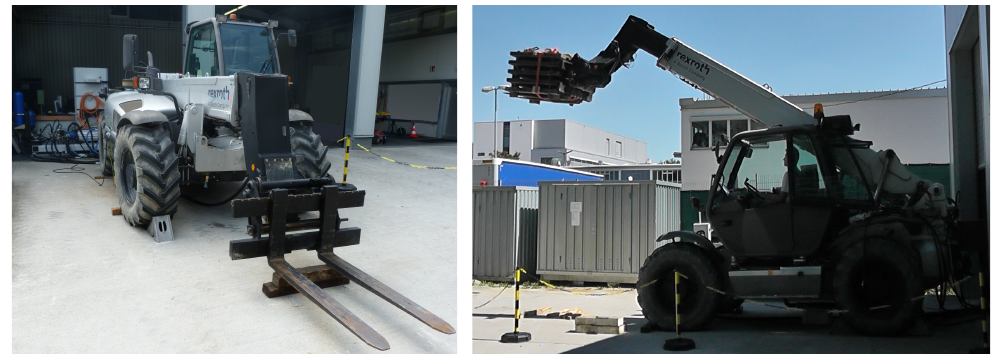
Figure 1. Views of the telehandler that was used for demonstration—Left: front view with the electro-hydraulic rig visible in the back—Right: side view with a 2.5 t steel-plate load strapped onto the